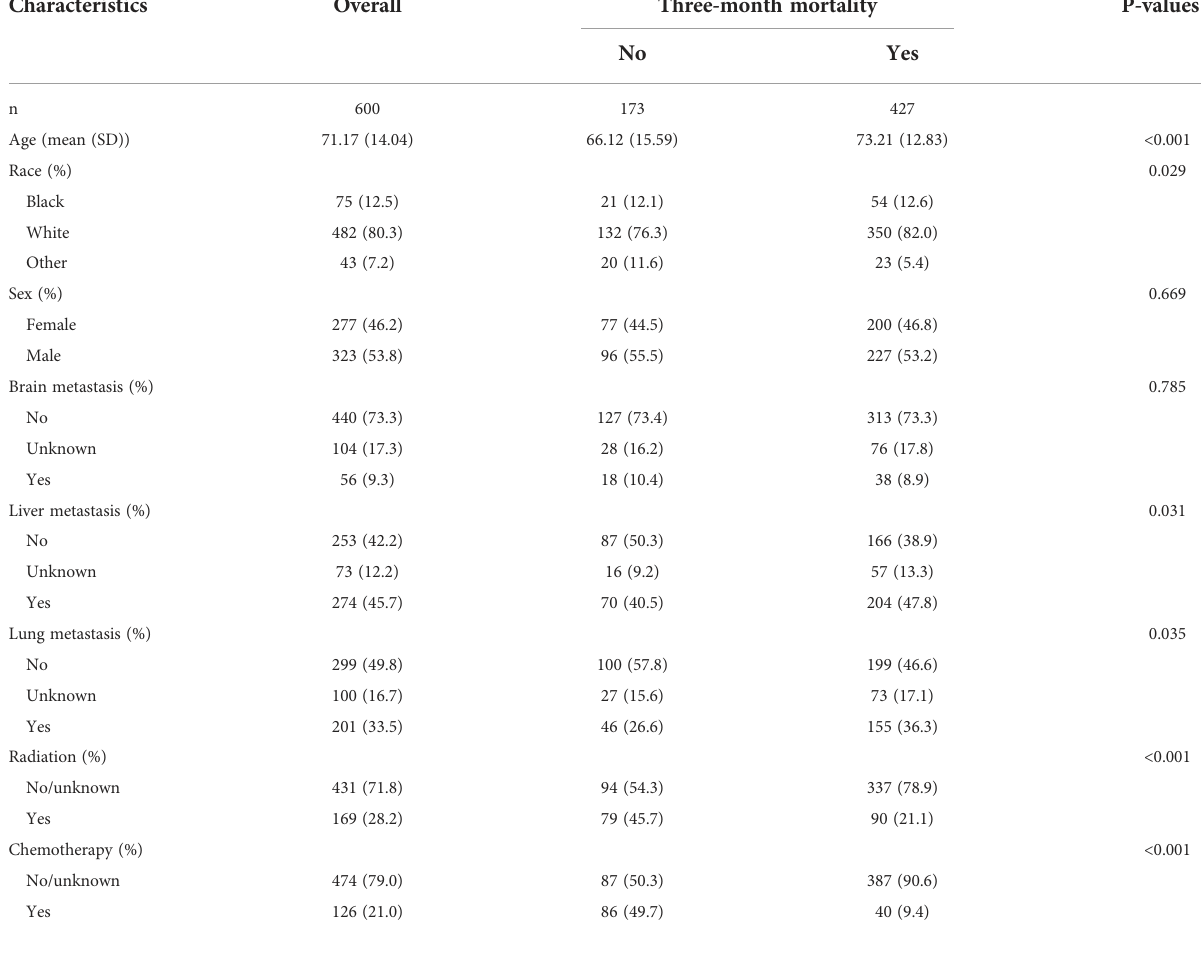
TABLE 2 Subgroup analysis between patients according to three-month mortality in the training cohort.